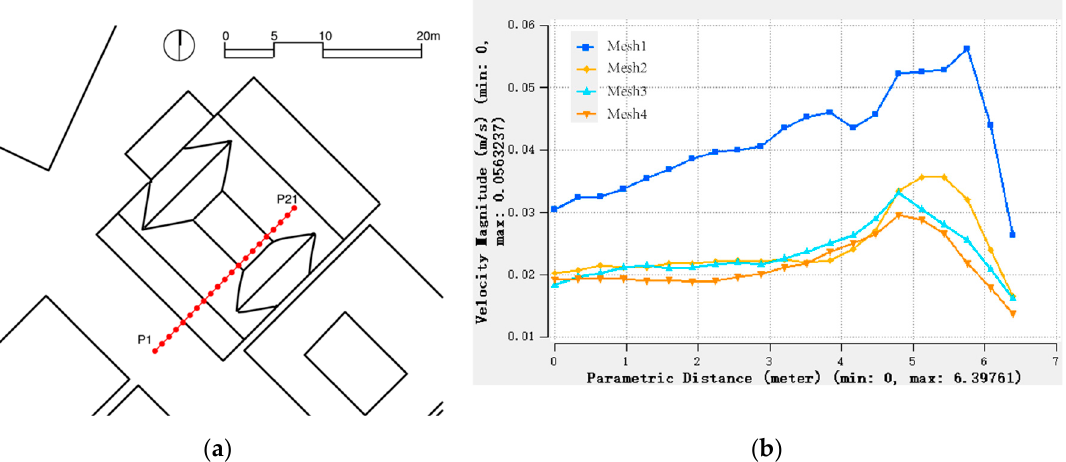
Figure 11. Verification of the mesh configuration for velocity magnitudes at 21 nodes: ( a ) 21 nodes along the depth of the courtyard, at a height of 1 m; and ( b ) air velocity magnitudes. Table 5. CFD Simulation